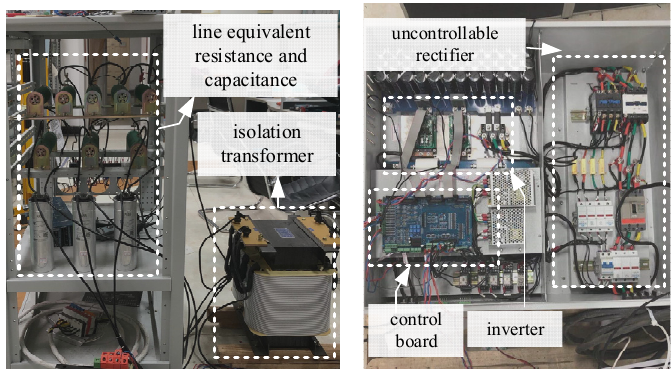
Figure 12. Flexible grounding device prototype. The experimental waveforms are shown in Figure 13. From top to bottom, they are waveforms of inverter output voltage U i , three-phase voltage U ABC0 (between lines and the neutral point) of distribution network, fault phase current I f , fault phase voltage U f , and three-phase current I ABC of distribution network.